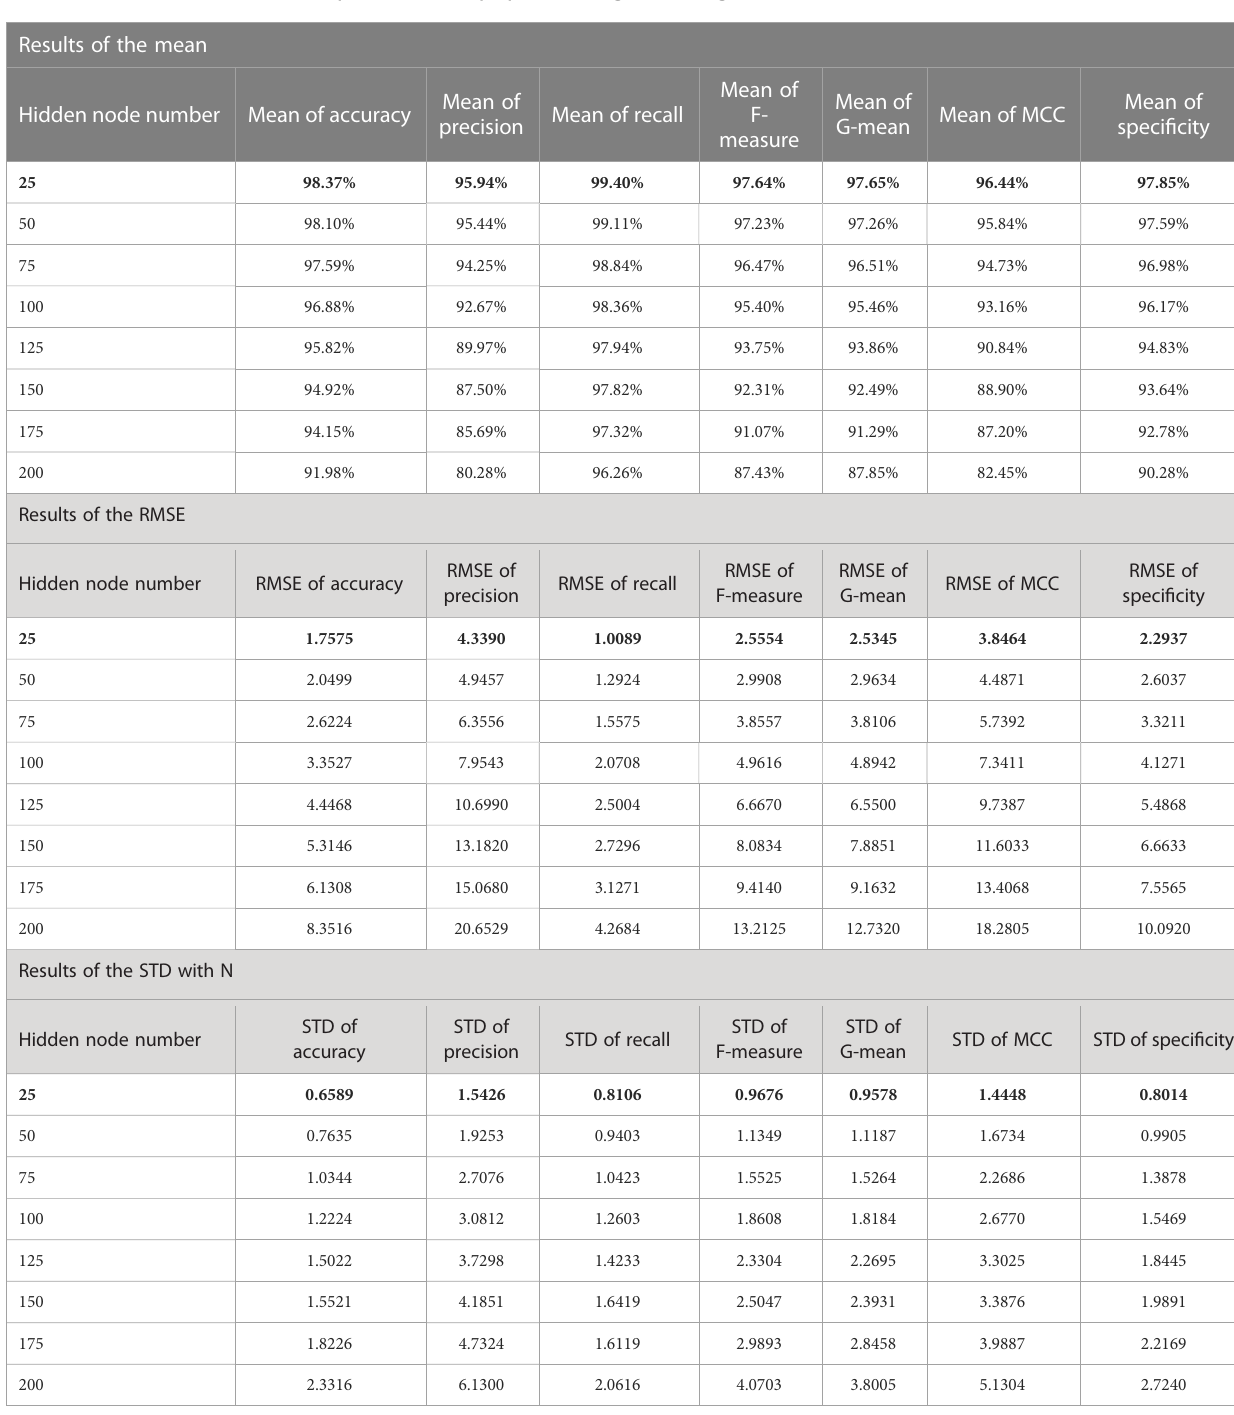
TABLE 6 The statistical results for all experiments of the proposed FLN algorithm using the